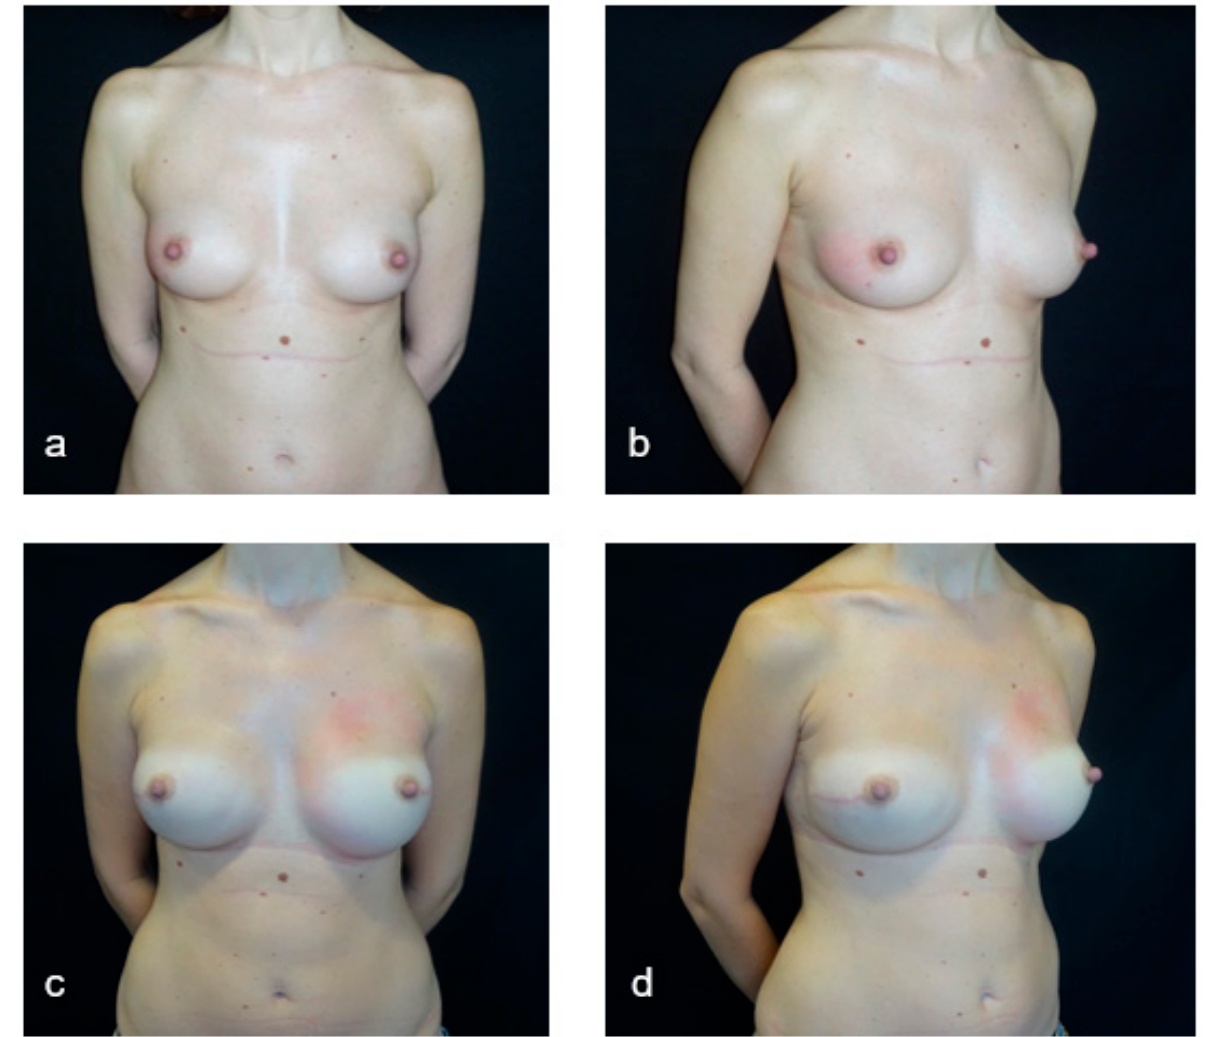
Figure 2. A case of nipple-sparing mastectomy and direct-to-implant submuscular reconstruction. ( a , b ) Preoperative pictures of a 47-year-old bilateral-breast cancer patient for whom bilateral nipple-sparing mastectomy and direct-to-implant submuscular reconstruction without acellular dermal matrix were planned. ( c , d ) Six-month postoperative pictures after bilateral nipple-sparing mastectomy through a radial lateral incision.